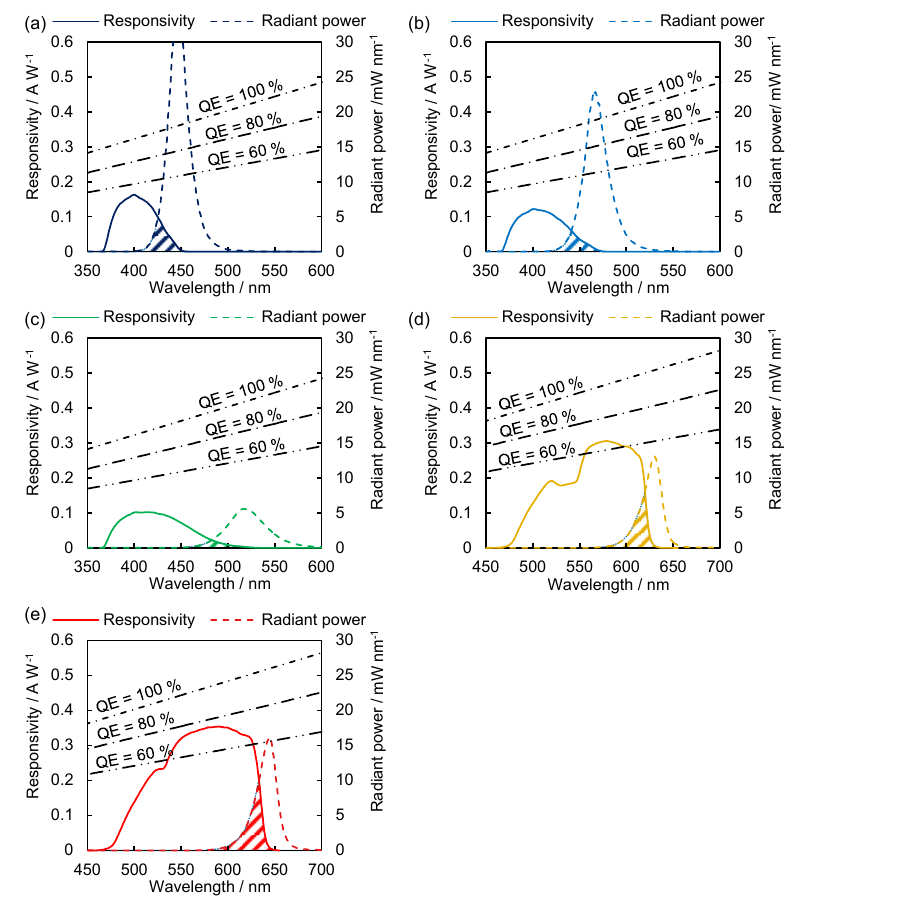
Figure 9. Spectral responsivity and spectrally resolved radiant power of the different LEDs compared to a quantum efficiency of 60, 80 and 100%. The hatched area gives a visual indication of the range of mutual absorption calculated by Eq. (7). (a) Royal blue LED; (b) blue LED; (c) green LED; (d) red-orange LED; (e) red